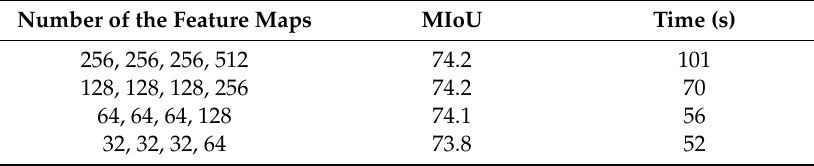
Table 2. The experiments for the adjustment of the number of feature